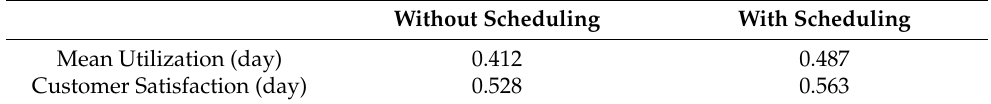
Table 5. The MU and CS on